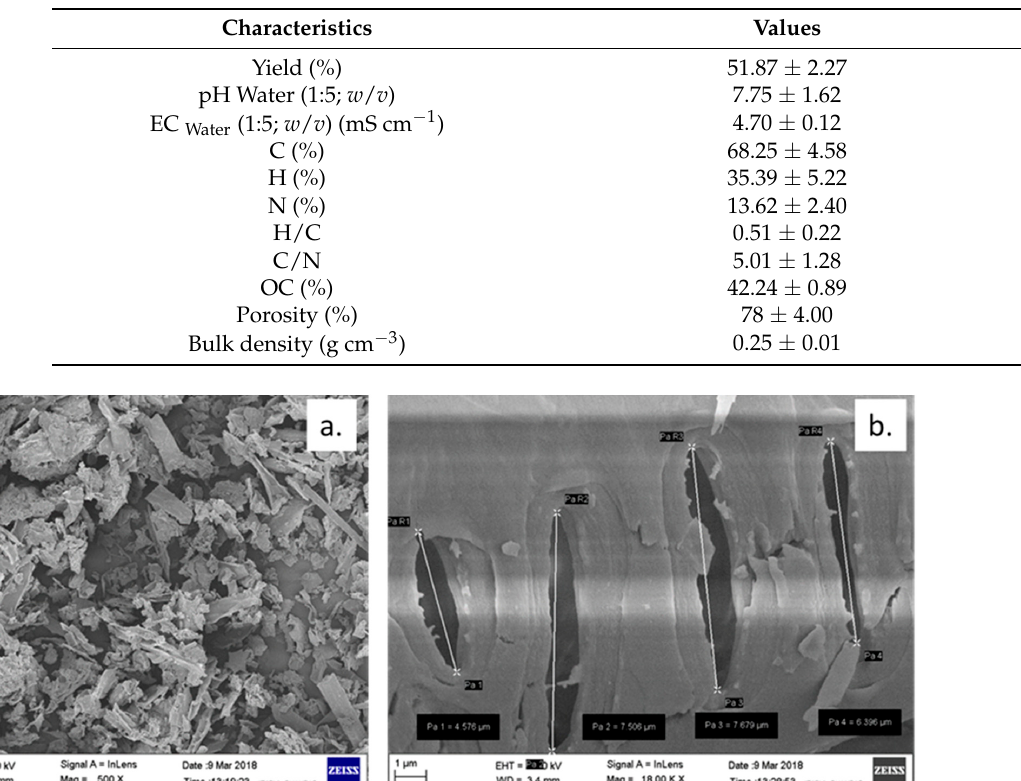
Table 1. Physio-chemical properties of C. procera biochar ( n = 5, mean ± standard deviation).